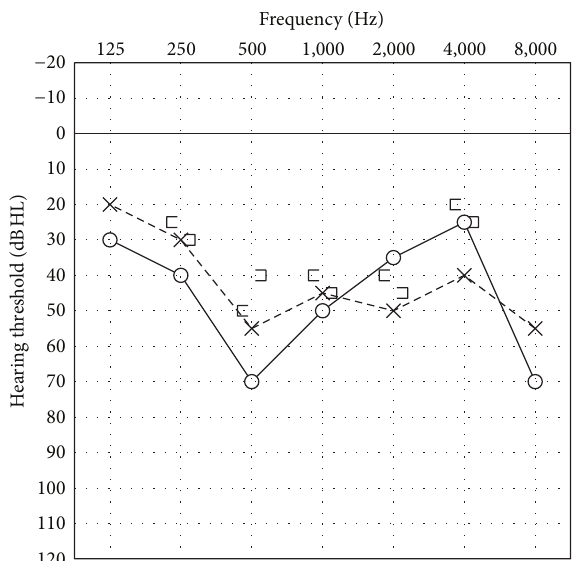
Figure 4: Pure tone audiogram for Case 2, showing moderate bilateral sensorineural hearing